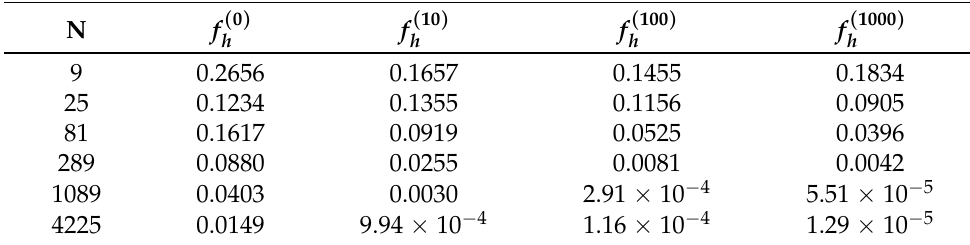
Table 2. RMSEs for ISPH, f